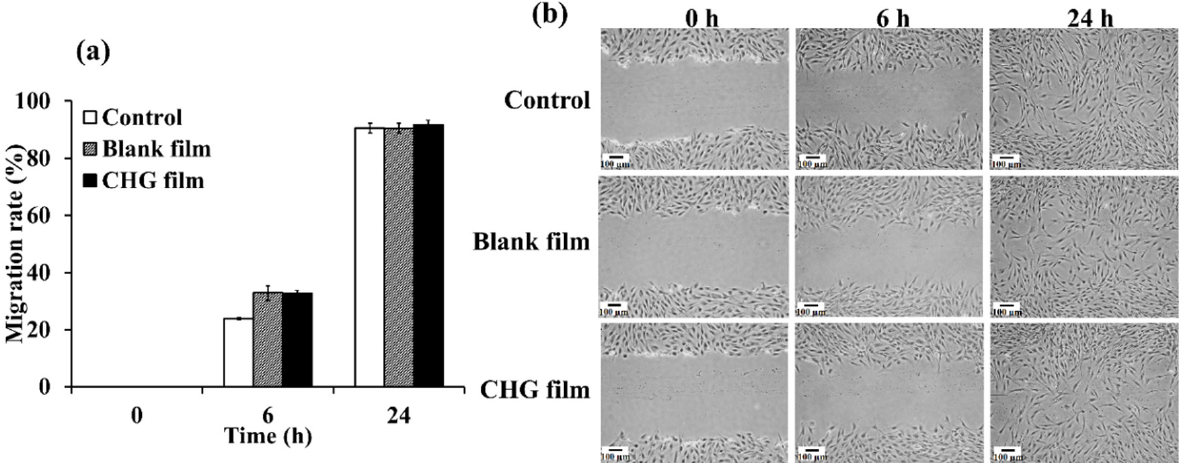
Figure 8. Evaluation of the cell migration in the in vitro scratch assay; ( a ) time-dependent effects of the blank and CHG films on the scratch closure rate. ( b ) Photographs of the NHF cells treated with the control, blank and CHG films at 0 h, 6 h, and 24 h after incubation.